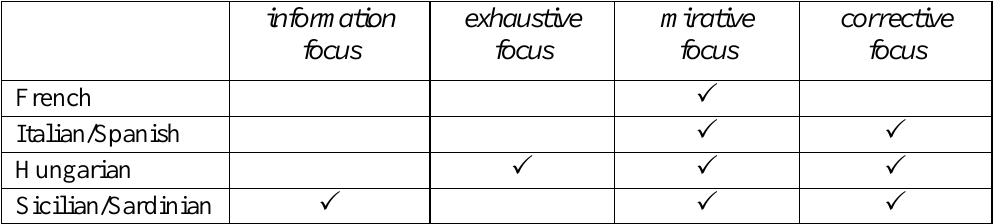
Table 1. Different types of focus in focus fronting across languages (Cruschina 2021: 10)